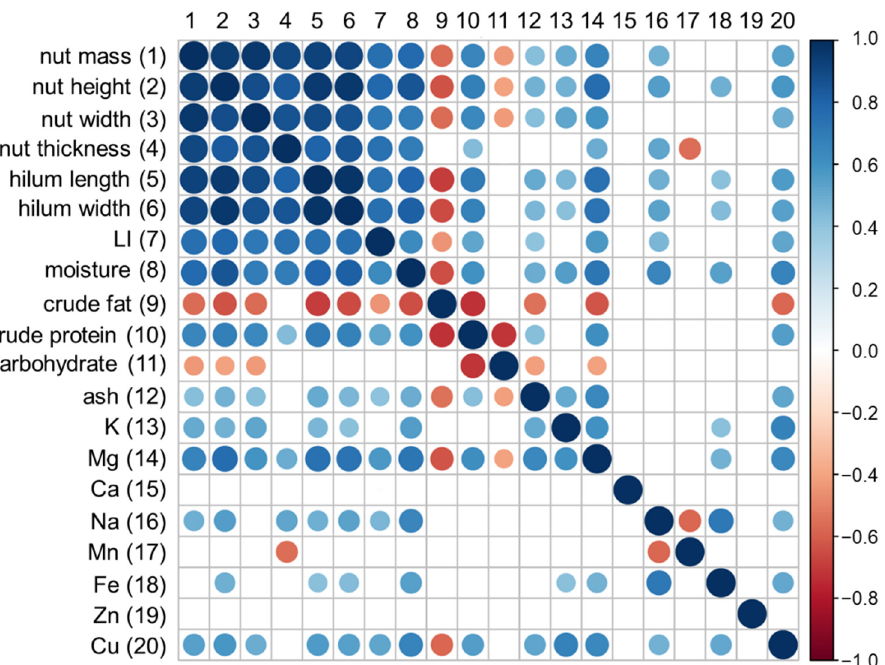
Figure 1. Correlations between morphometric and chemical variables in the studied traditional and hybrid chestnut varieties. Positive correlations are displayed in blue and negative correlations in red color. Color intensity and the size of the circle are proportional to the correlation coefficients. Non-significant values, p > 0.01, are blank.